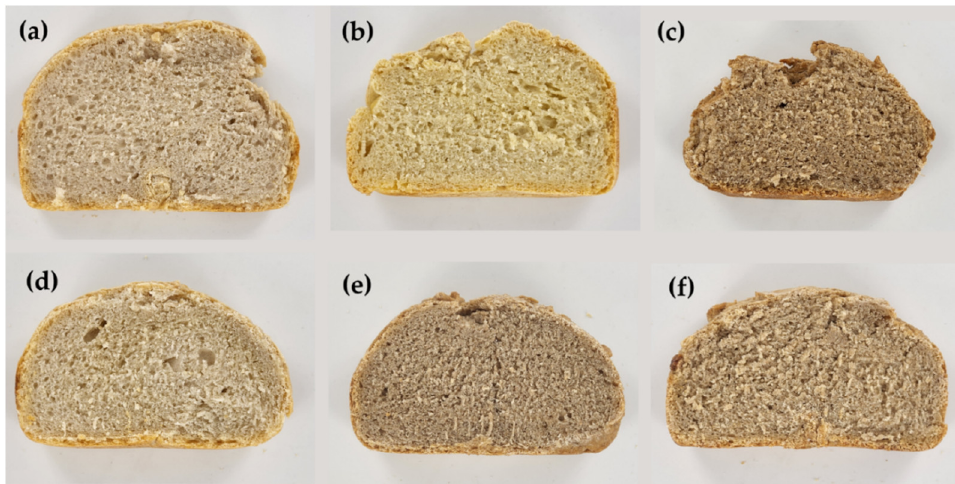
Figure 1. Slices of the different treatments of sourdough bread made with different types of flour ( a ) soft wheat, ( b ) semola, ( c ) Emmer wheat, ( d ) soft wheat + semola, ( e ) soft + Emmer wheat, and ( f ) semola + Emmer wheat developed for this study.